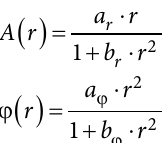
00.010.020.030.040.050.06 R B E 10 2 Phase Offset (deg) Fig. 5. Dependence of error probability for BPSK modulation scheme on a phase offset in the downlink: dots – without coding, circles – with convolutional coding (rate 3/4, constraint length K = 7); receiver noise temperatures 290 K, free space path loss 250 dB; HPA back-off level 7 dB; frequency offset is equal to zero; antennas gain G = 10; satellite phase noise is negligible Fig. 7. Signal constellation for BPSK modulation scheme for Fig. 6. End signal constellation for BPSK modulation scheme the high level of phase noise (–48 dBc/Hz, frequency offset for a phase offset 20 o in the downlink: with convolutional 100 Hz): with convolutional coding (rate 3/4, constraint length coding (rate 3/4, constraint length K = 7); aircraft receiver K = 7); aircraft receiver noise temperatures 0 K; free space path noise temperature 0 K; free space path loss 160 dB; loss 160 dB; HPA back-off level 7 dB; phase offset is equal to HPA back-off level 7 dB; frequency offset is equal to zero; d 1 = zero; d 1 = d 2 = 1.0 d 2 =1.0 m; satellite phase noise is negligible